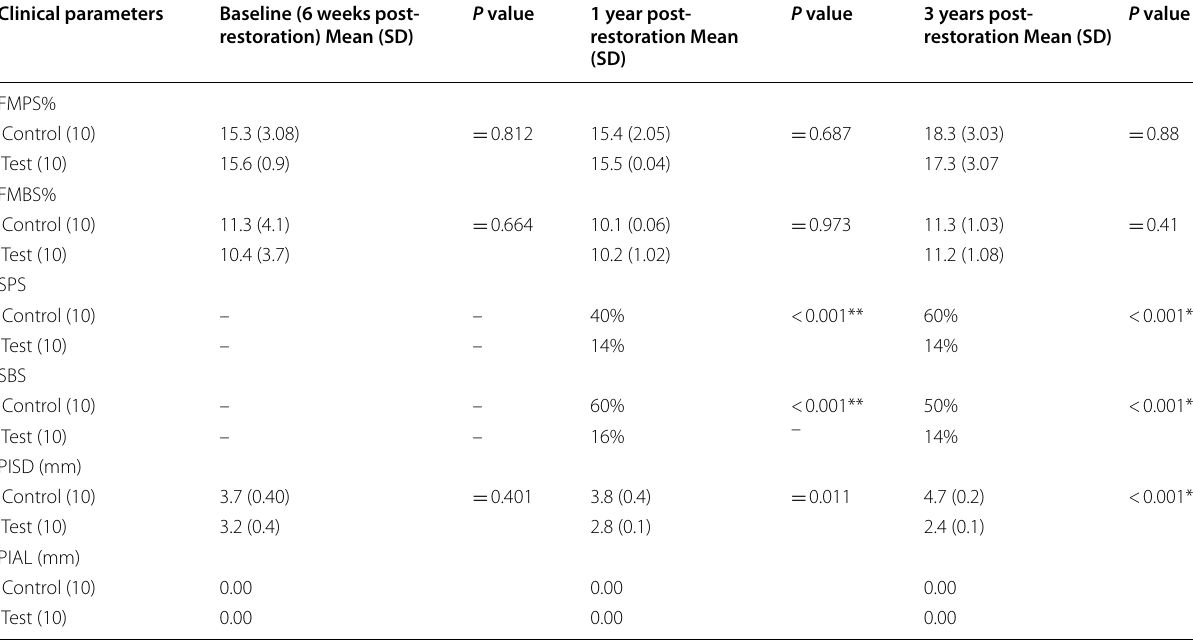
Table 2 Intergroup comparison of clinical parameters at different time points Clinical